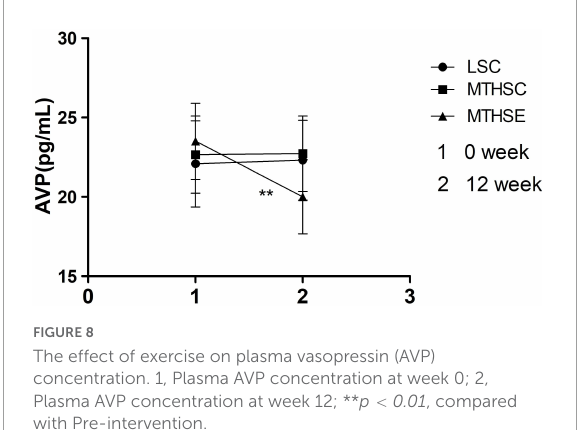
FIGURE8 The effect of exercise on plasma vasopressin (AVP) concentration. 1, Plasma AVP concentration at week 0; 2, Plasma AVP concentration at week 12; ** p < 0.01 , compared with Pre-intervention.